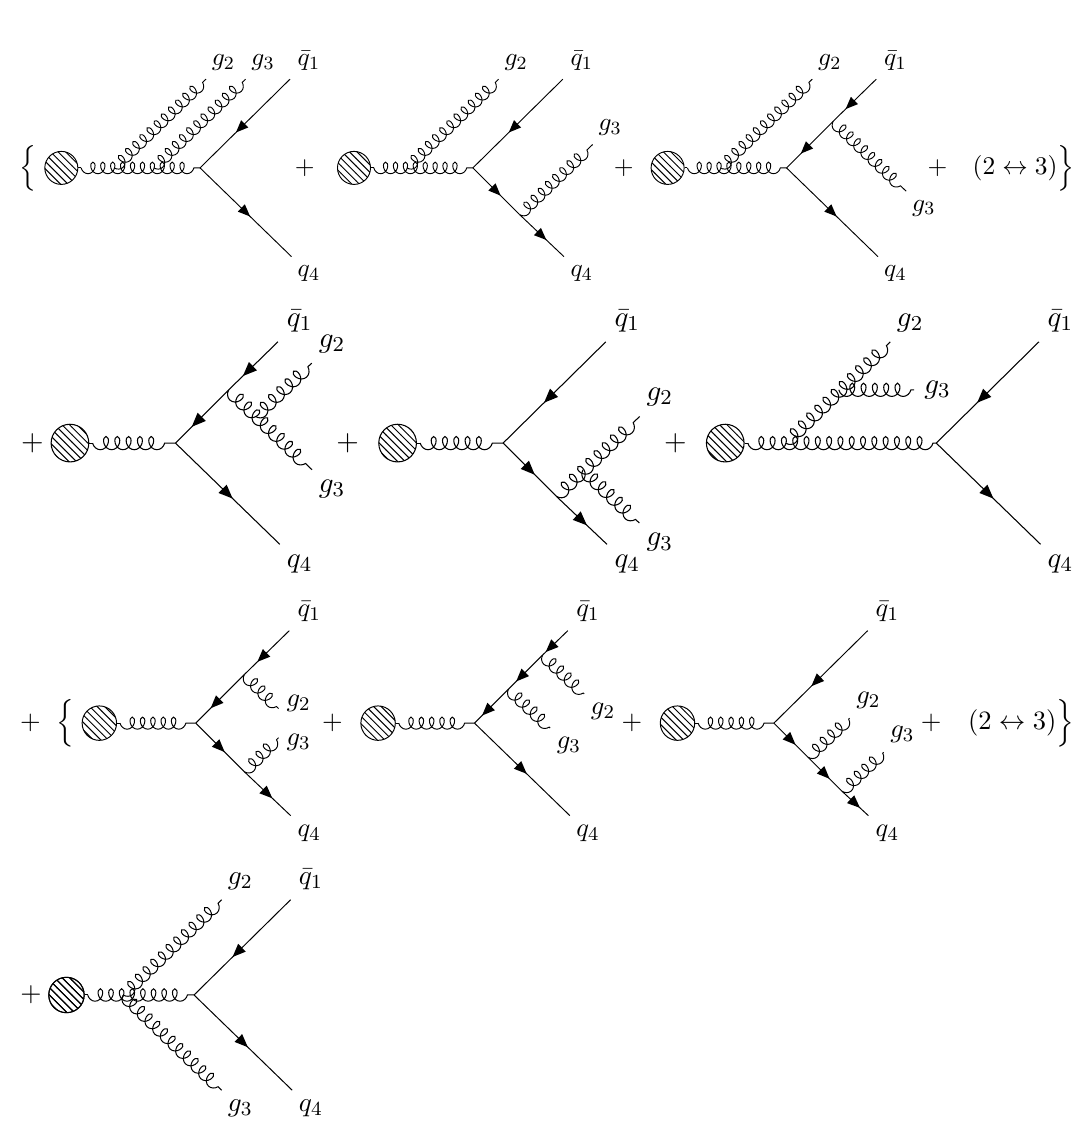
Figure 2 . The diagrams contributing to the collinear decay g ! (cid:22) q 1 g 2 g 3 q 4